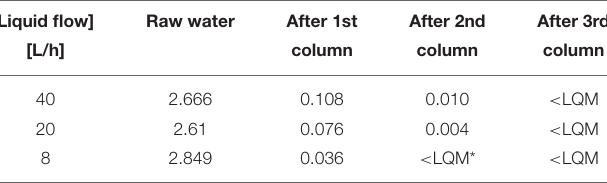
Liquid flow] Raw water After 1st After 2nd After 3rd column column column